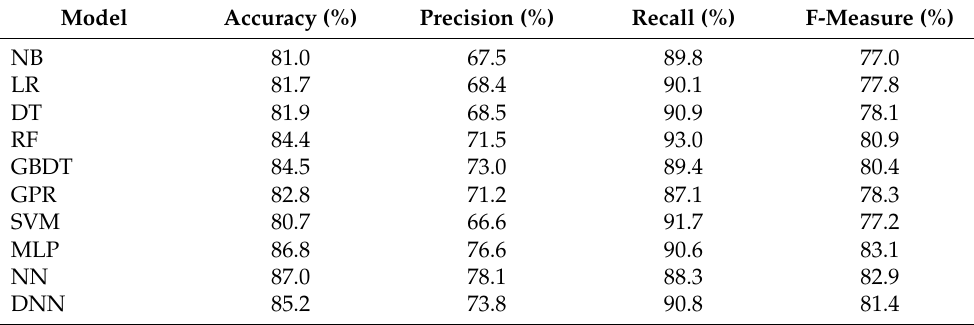
Table 10. Comparison of machine learning models with analysis using feature selection.